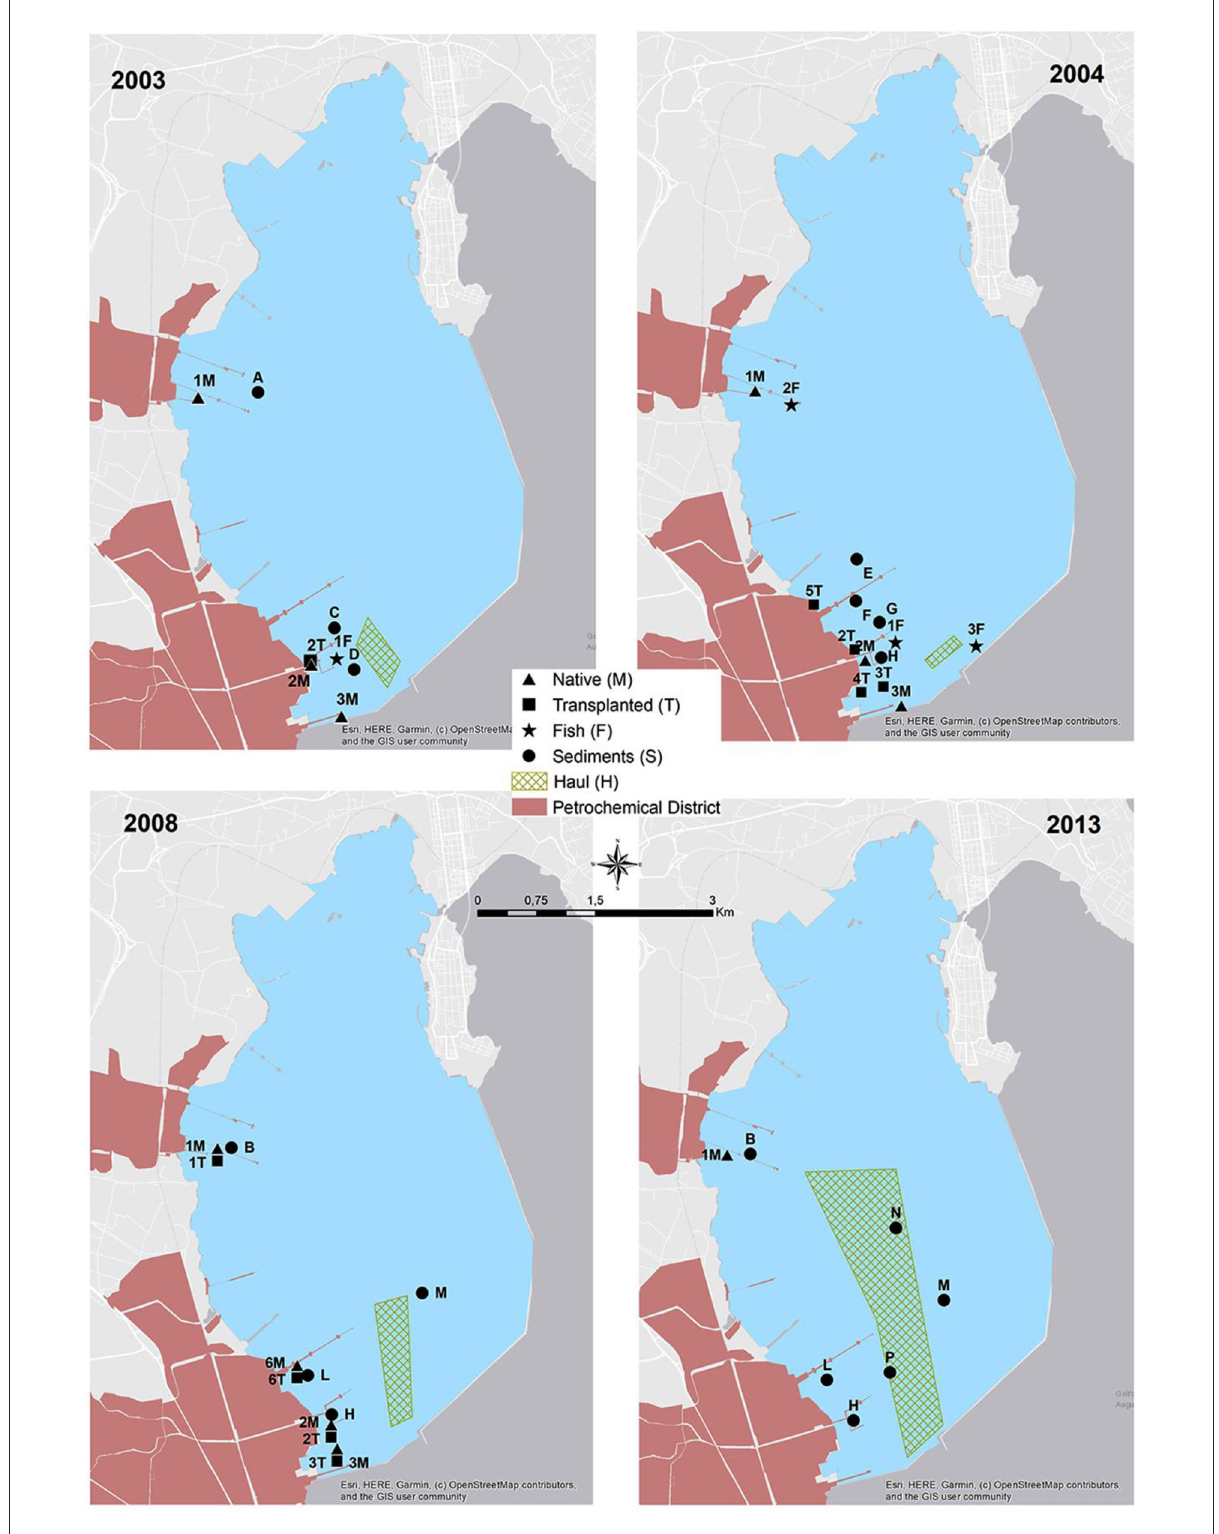
FIGURE2 Sediment sampling stations (from A to P), native mussels stations (from 1M to 6M), transplanted mussels stations (from 1T to 6T), fish stations (from 1F to 3F) from 2003 to 2013 and hauls for different years (1H, 2003; 2H, 2004; 3H, 2008; 4H,